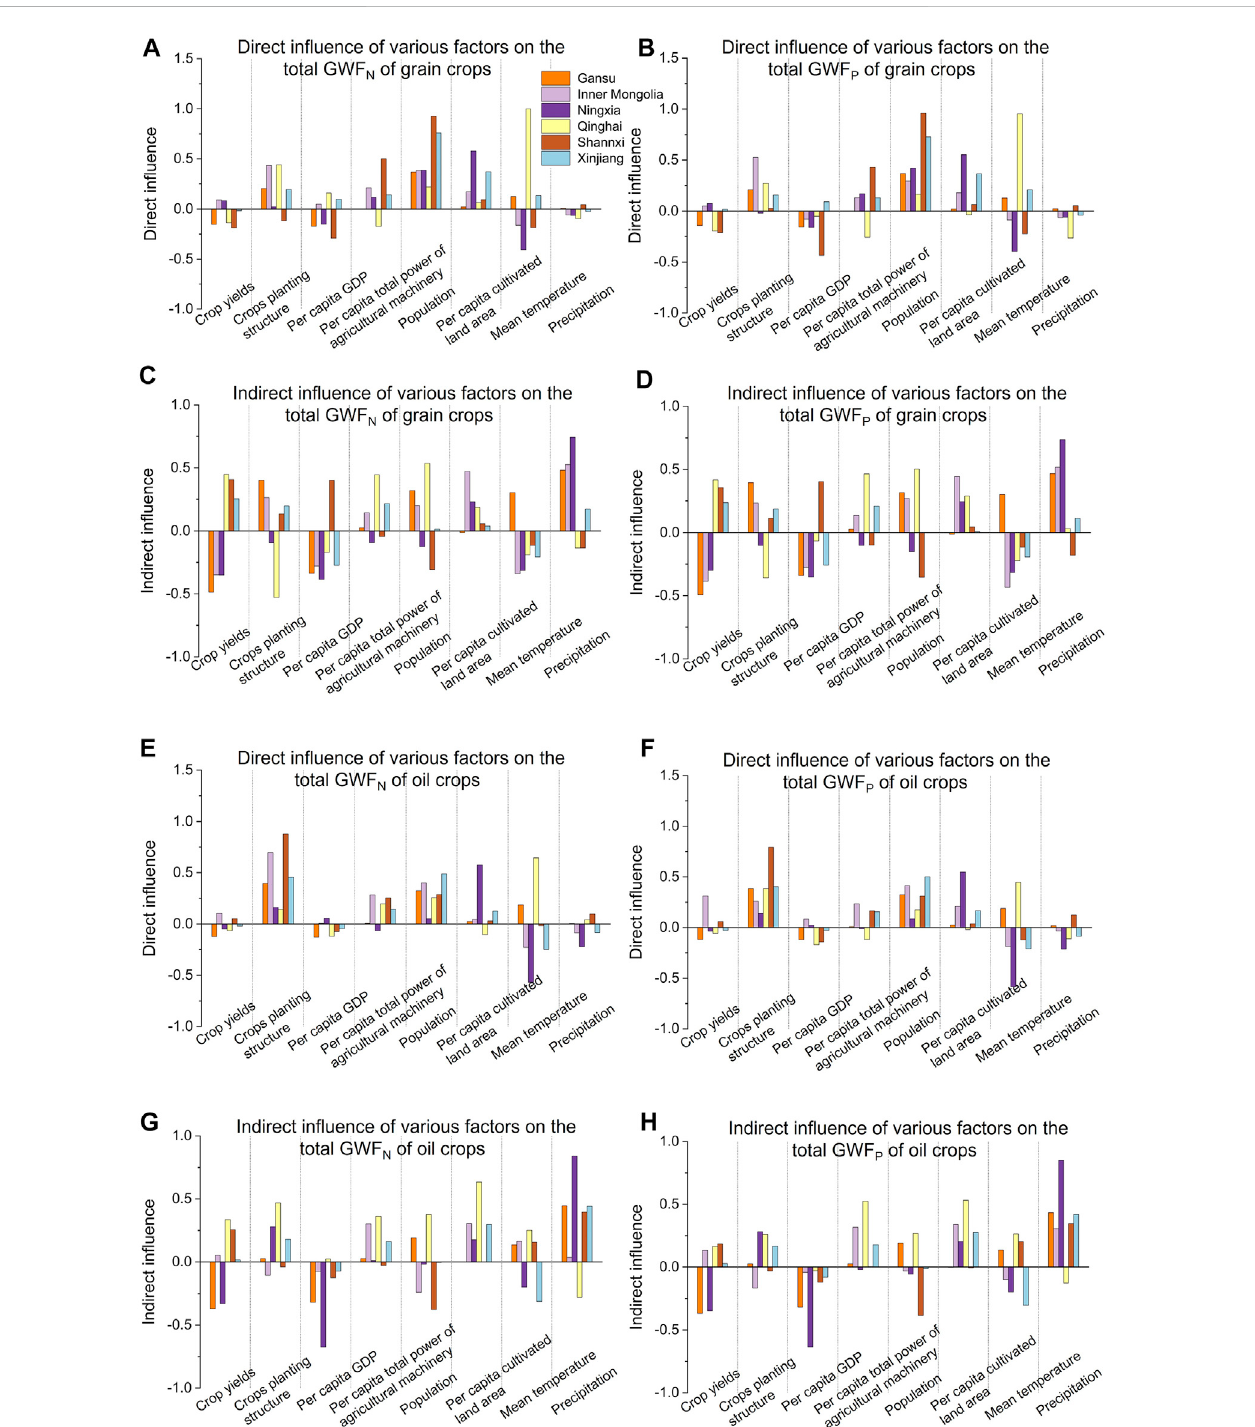
FIGURE 6 Direct and indirect effects of various factors on the total GWF of grain crops and oil crops in the six western provinces: (A,B) direct effects of various factorsonthetotalGWFrelatedtoN(left)andP(right)ofgraincrops; (C,D) indirecteffectsofvariousfactorsonthetotalGWFrelatedtoN(left)andP(right)of graincrops; (E,F) directeffectsofvariousfactorsonthetotalGWFrelatedtoN(left)andP(right)ofoilcrops; (G,H) indirecteffectsofvariousfactorsonthetotal GWF related to N (left) and P (right) of oil